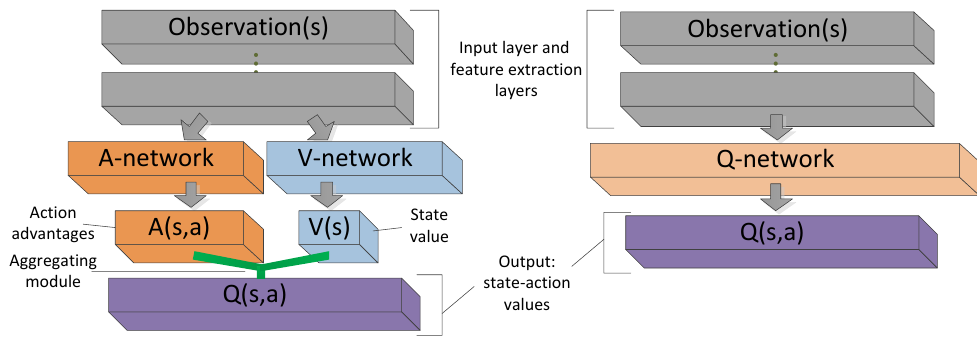
Figure 1. Dueling Q -network ( left ) and standard single-stream Q -network ( right ). Both networks have the same input and feature extraction module; the outputs are state-action values. The difference is that dueling network adopts two sequences (streams) networks to estimate state values and action advantages, and then combines them to indirectly generate the Q -values; The Q -network has a single sequence network and it directly produces Q -values’